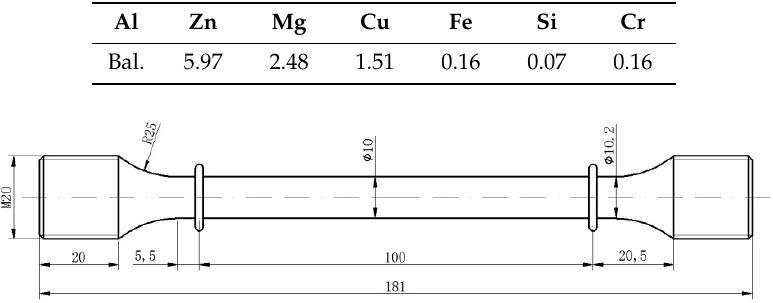
Table 1. Chemical composition of 7B04 aluminum alloy (wt. %).